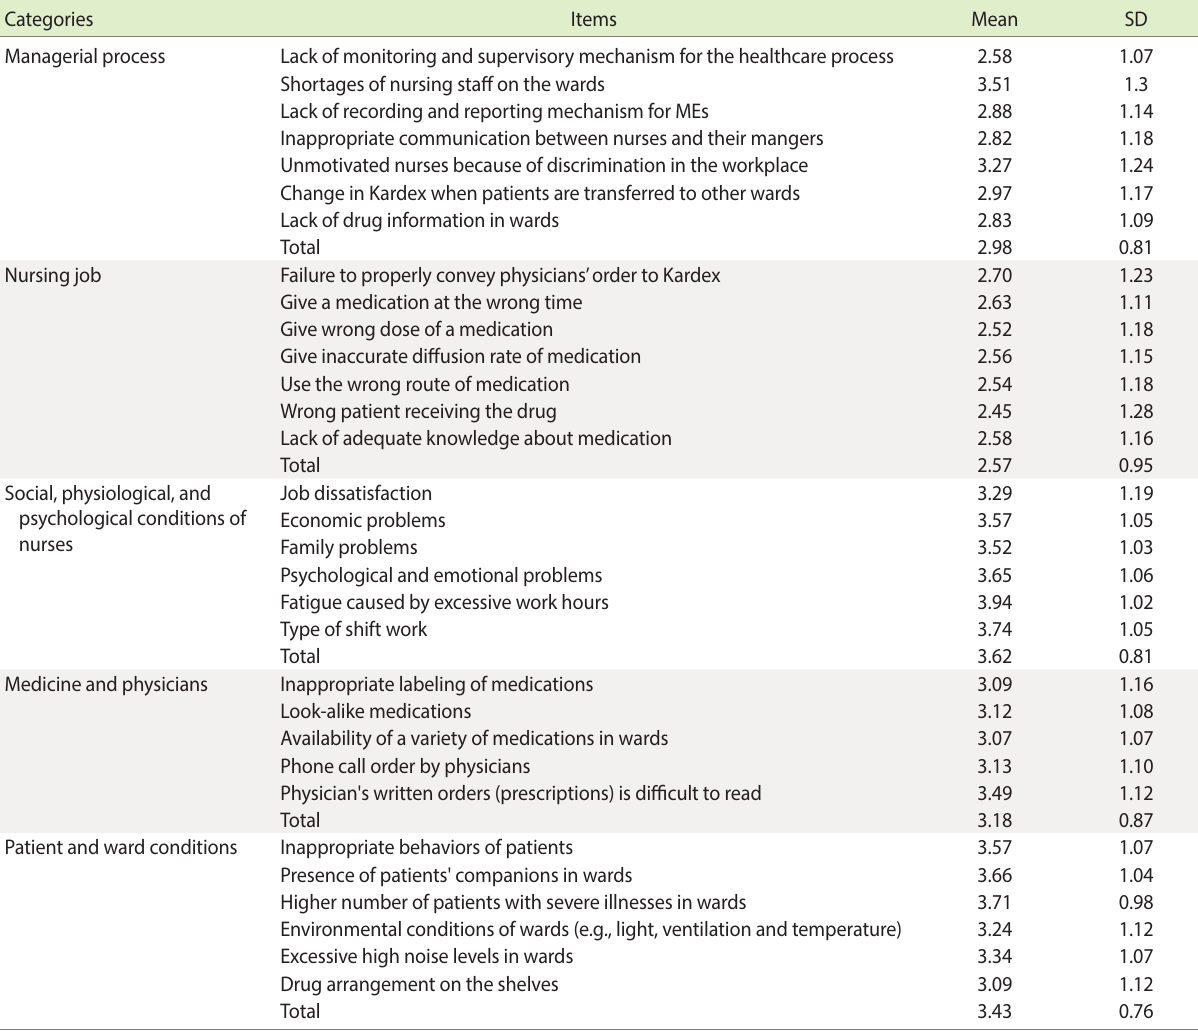
ME, medication error; SD, standard